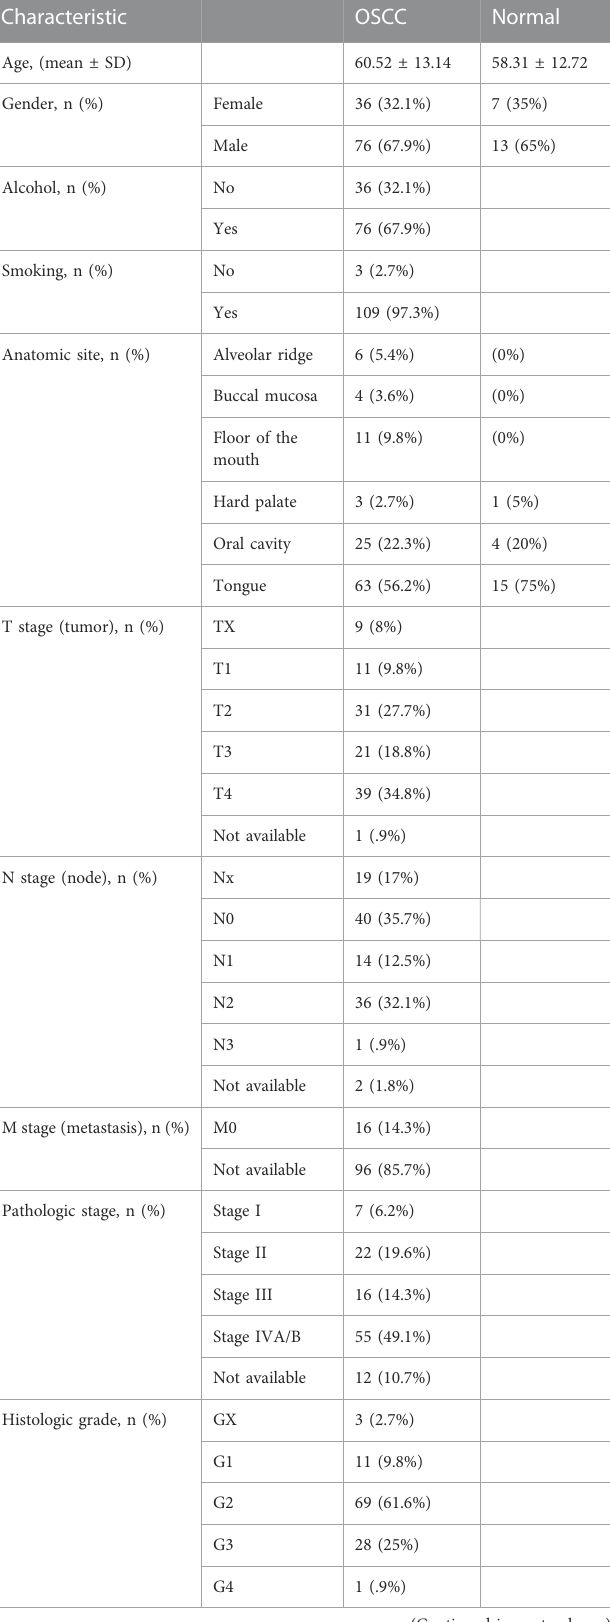
TABLE 1 General characteristics of OSCC